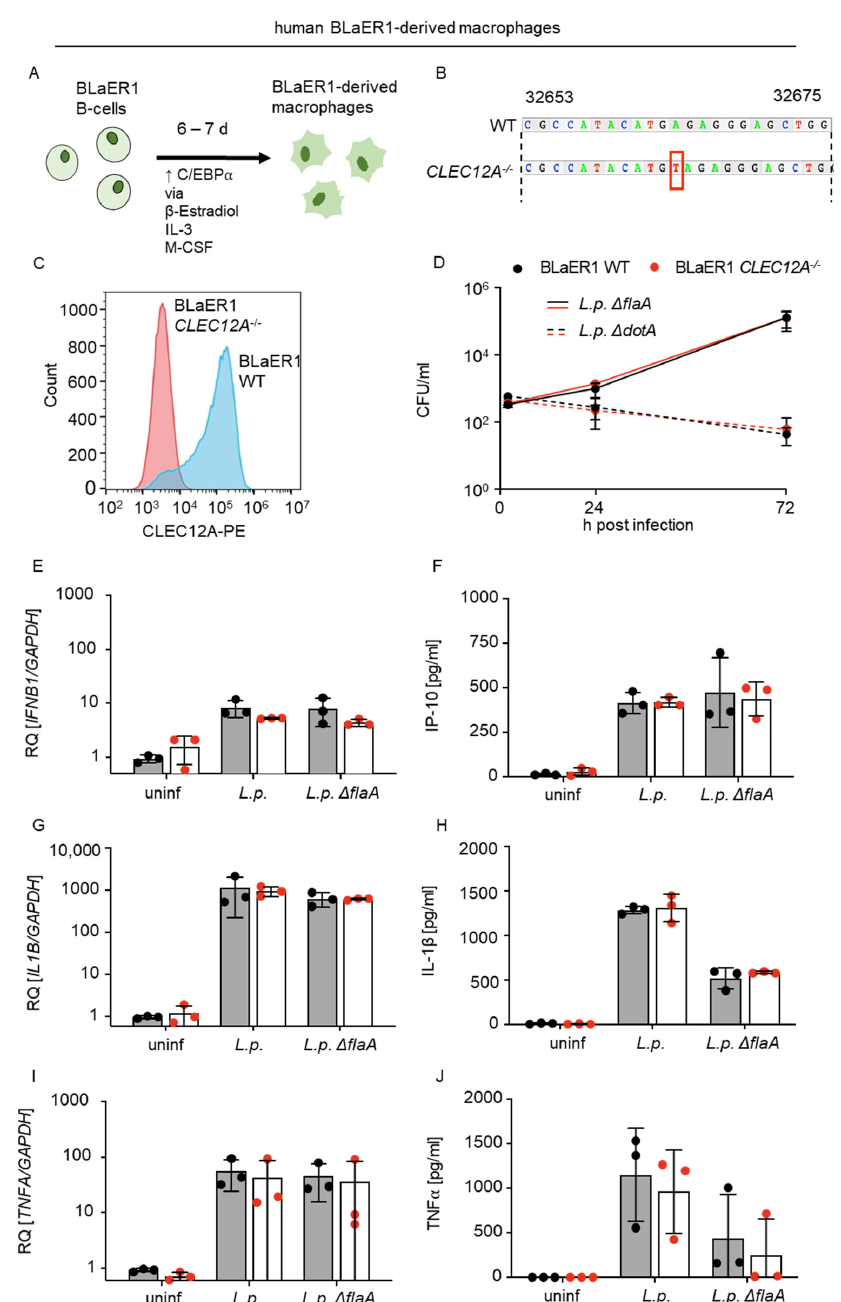
Figure 3. CLEC12A does not affect the replication of L. pneumophila or the production of proinflammatory cytokines and type I IFNs by BLaER1-derived human macrophages. ( A ) BLaER1 cells were transdifferentiated into BLaER1-derived macrophages by stimulation of the transcription factor C/EBP ⍺ with β -estradiol, IL-3 and M-CSF for 5 to 7 days. ( B ) BLaER1 CLEC12A − / − cells were generated by introducing a frameshift of one base into CLEC12A (see red box) by CRISPR/Cas9. ( C ) The loss of CLEC12A in BLaER1 cells was confirmed by flow cytometry, using an anti-CLEC12A- PE labeled antibody. ( D ) The replication of L. pneumophila ( L.p. ) ∆ flaA and ∆ dotA in BLaER1 WT and CLEC12A − / − cells was assessed by infecting cells at MOI 0.1 and evaluating CFUs at 2, 24 and 72 h after infection. BLaER1 WT and CLEC12A − / − cells were infected with L.p. WT and ∆ flaA at MOI 10. The expression levels of IFNB1 ( E ), IL1B ( G ) and TNFA ( I ) were measured after 8 h by qRT-PCR and compared with uninfected controls. Data are shown as the relative quantification (RQ) of the